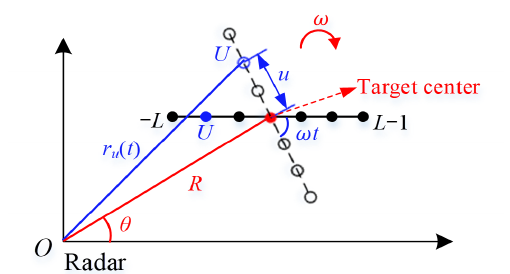
Figure 4. Schematic diagram under the case that the target